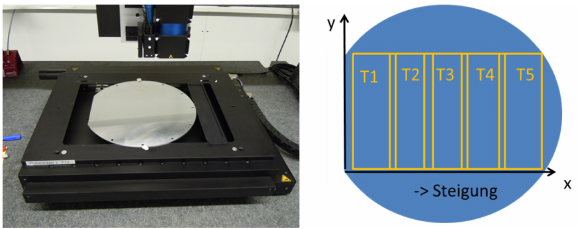
Fig. 8. A degrader disk mounted on the MicroProf ® -table (left) and the schematic drawing of the disk with the overlapping measurement areas T1 – T5.